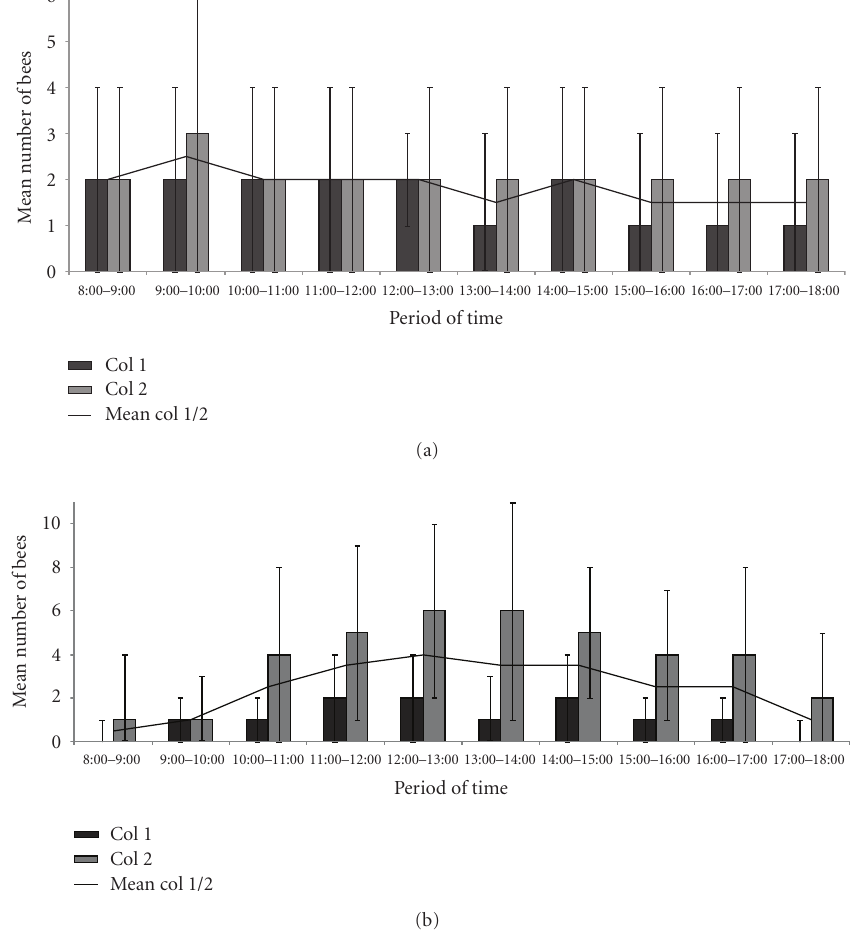
Figure 5: Resin collection patterns of two colonies of Plebeia remota in the reproductive phase (a) and in the diapause (b).